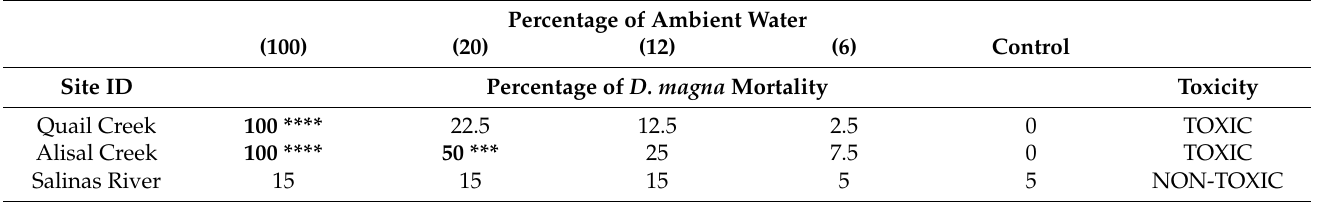
Table 2. Mortality of D. magna throughout a 96 h exposure to serial dilutions of water samples from 3 sites located throughout the Salinas River (CA, USA) collected November 2019 (after first